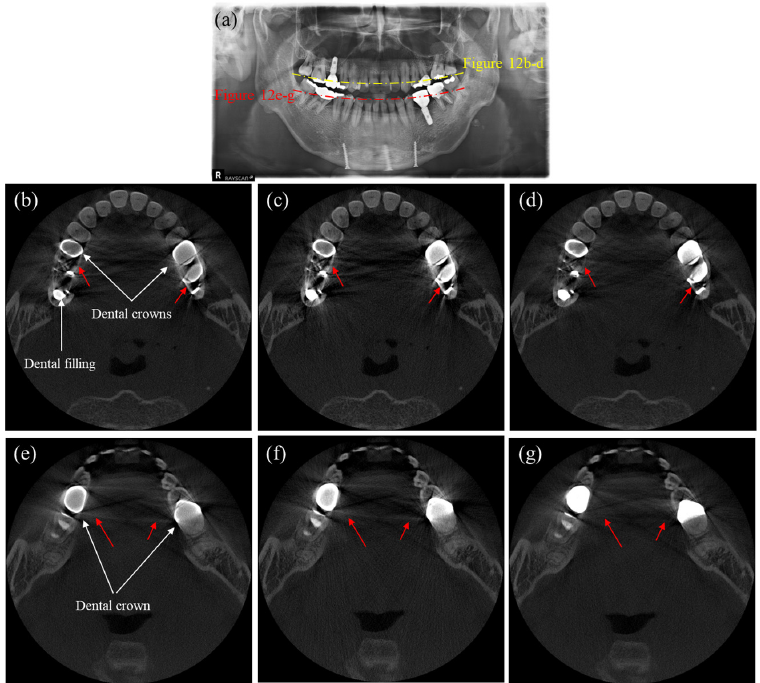
Figure 12. Images of a patient having multiple dental fillings and dental implants. ( a ) The panoramic X-ray image, ( b , e ) the uncorrected CT images, ( c , f ) the CT images corrected by the DSC method, and ( d , g ) the CT images corrected by the proposed method. (Contrast window is [ − 1117~8564] in Hounsfield Unit).